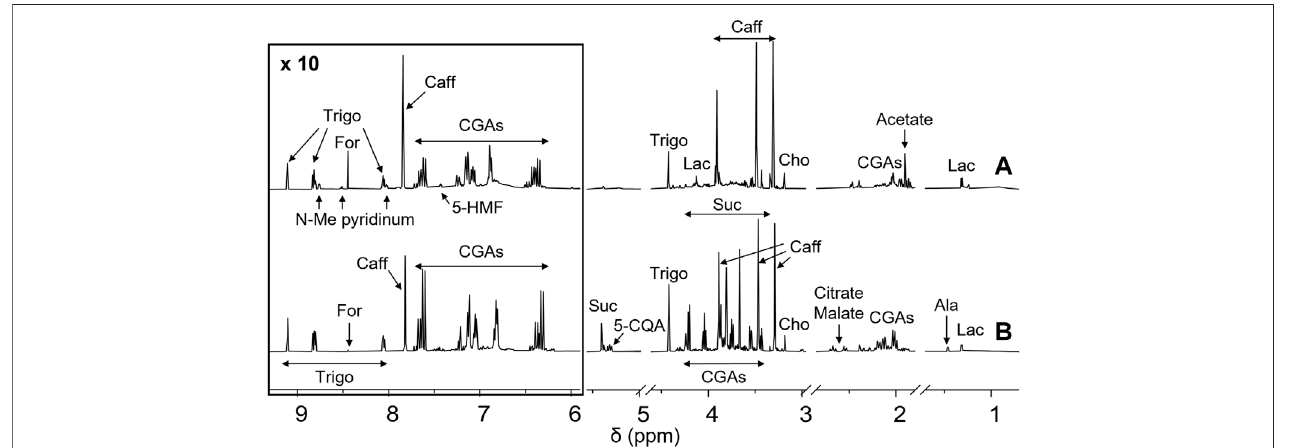
FIGURE 1 | NMR pro fi ling of coffee samples. 1 H-NMR spectra of Robusta green (A , bottom ) and roasted (B , up ) coffee extracts from Brazil. Each sample, containing 5 mg/ml of extract, was dissolved in a 10 mM deuterated phosphate buffer, pH 7.4, DSS 1 mM. Spectra were acquired at 25 ° C and 600 MHz. Assignments oftheresonancesofthemostimportantmetabolitesareshown(5-HMF,5-hydroxymethylfurfural;Trigo,trigonelline;N-Mepyridinium,N-methylpyridinium;For,formate; Caff, caffeine; CGAs, chlorogenic acids; Suc, sucrose; 5-CQA, 5- O -caffeoylquinic acid; Cho, choline; Ala, alanine; Lac, lactate).